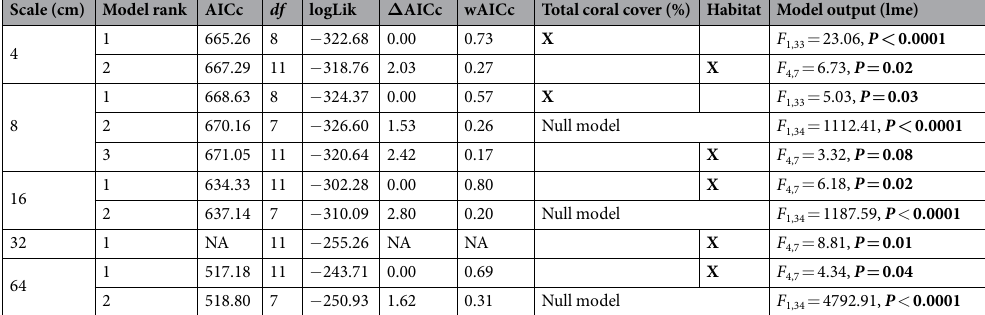
F 4,7 = 6.18, P = 0.02